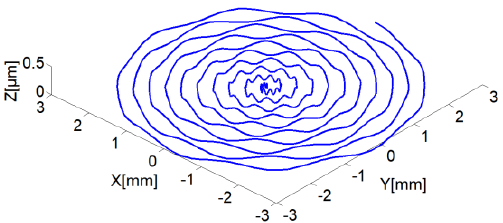
Figure 7. Tool tip trajectory with the tilting motion of the spindle shaft in Z axis.